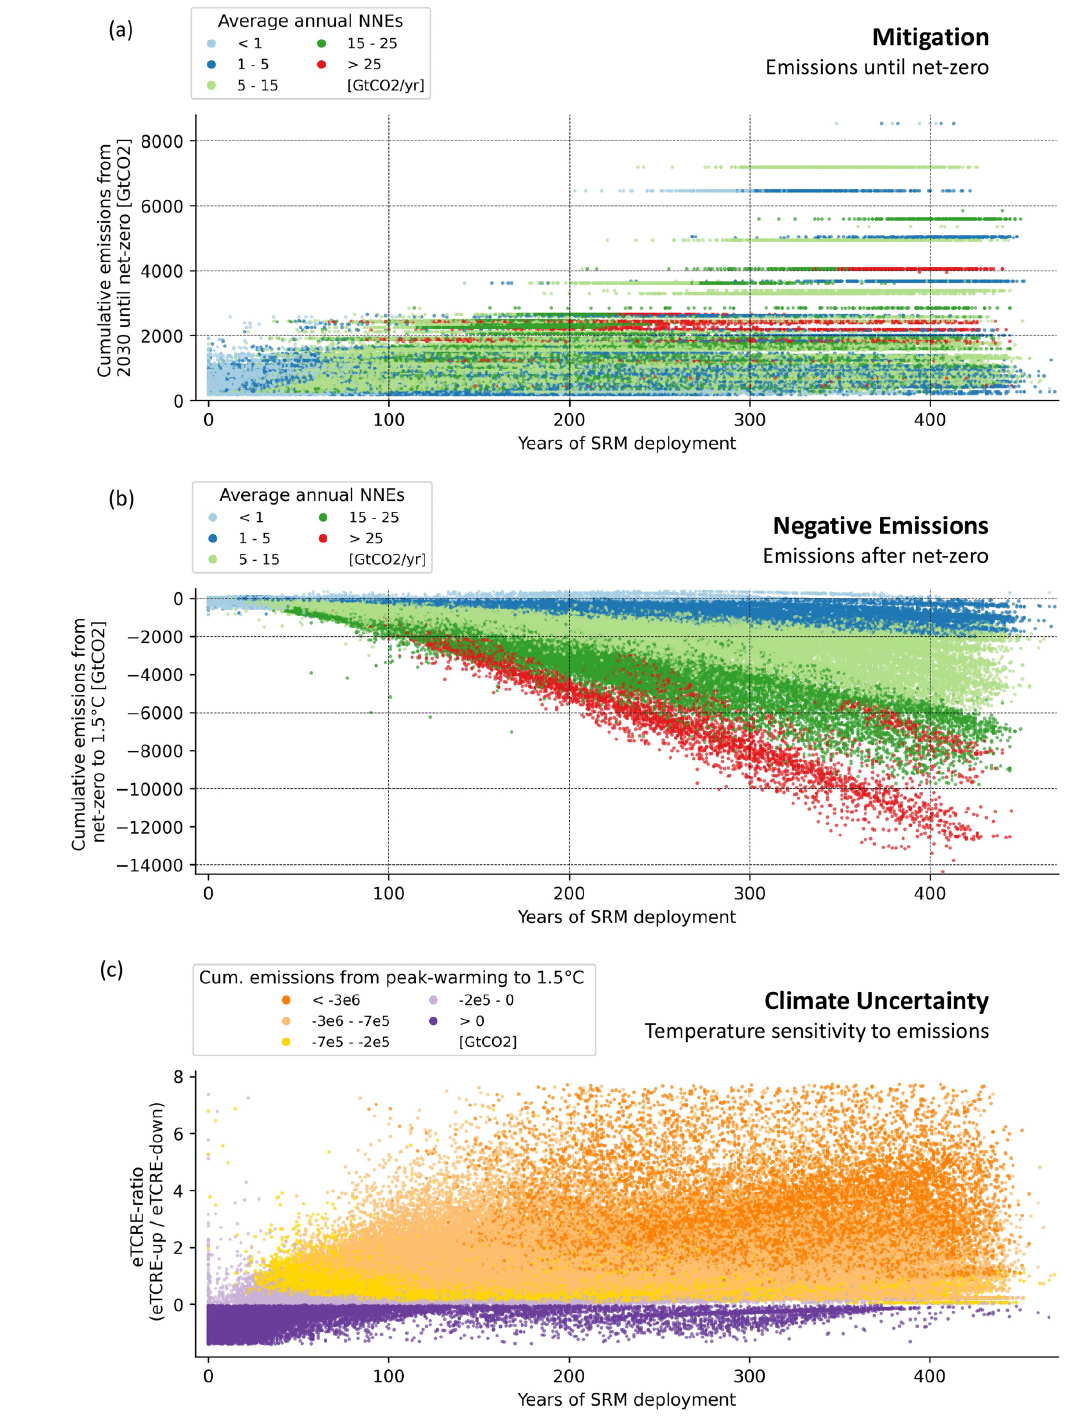
Figure 4. Interdependencies of mitigation, negative emissions and climate uncertainty with SRM deployment length. (a) Relationship be- tween cumulative CO 2 emissions from 2030 until net-zero CO 2 and SRM deployment length. Colour coding is according to annual average NNEs in Gt CO 2 yr − 1 . (b) Relationship between cumulative CO 2 emissions from net-zero CO 2 until the reattainment of 1.5 ◦ C and SRM deployment length. Colour coding is according to annual average NNEs in Gt CO 2 yr − 1 . (c) Relationship between eTCRE ratio and SRM deployment length. Colour coding is according to cumulative CO 2 emissions from the time of peak warming until the reattainment of 1.5 ◦ C. Plot shows data points that fall in the 1st–99th percentile range.